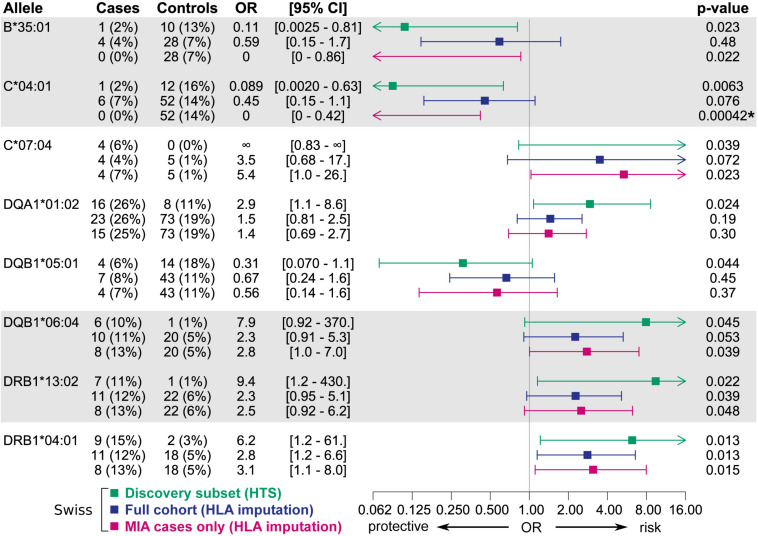
Associations of candidate alleles from the discovery subset at two-field resolution in the full Swiss cohort and in an analysis including only cases with MIA. HLA typing results obtained by HTS were used if available, else typing results obtained by HLA imputation were used. Alleles in strong linkage disequilibrium are highlighted in one contiguous gray block. P-values < 0.01 in the full cohort are highlighted with an asterisk.